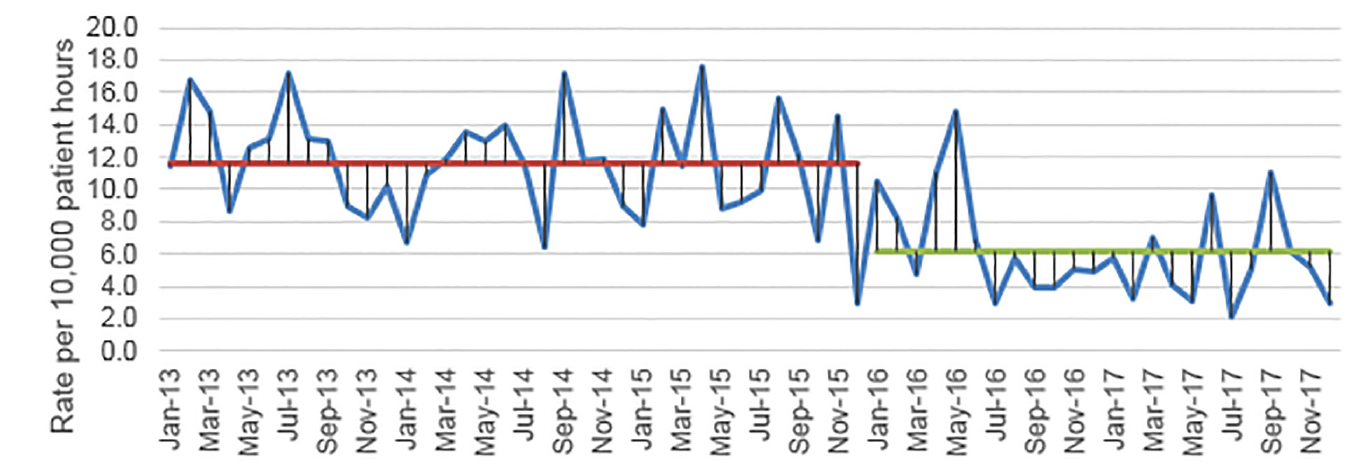
Figure 1. Hospital Clostridium difficile rates 2013-2017 before (red) and after (green) sepsis protocol